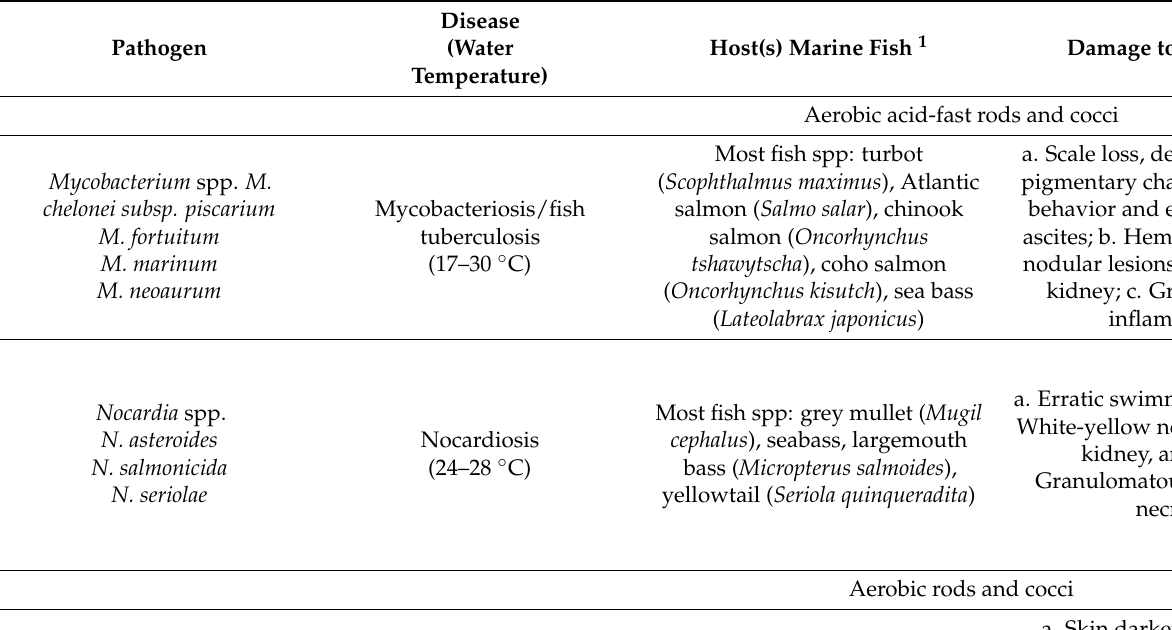
Table 1. Host–pathogen interactions of significant marine Gram-positive